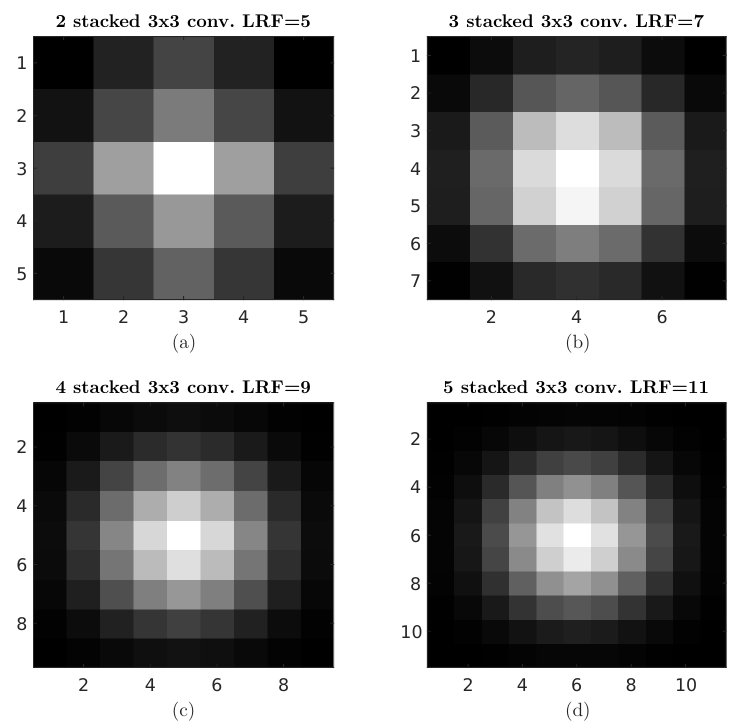
Figure 5. Stacking convolutional kernels’ effect on spatial resolution, where it can be seen that as the number of stacked layers increases, the output results favour the results toward the centre more, where the lowest weights are towards the corners of the input.